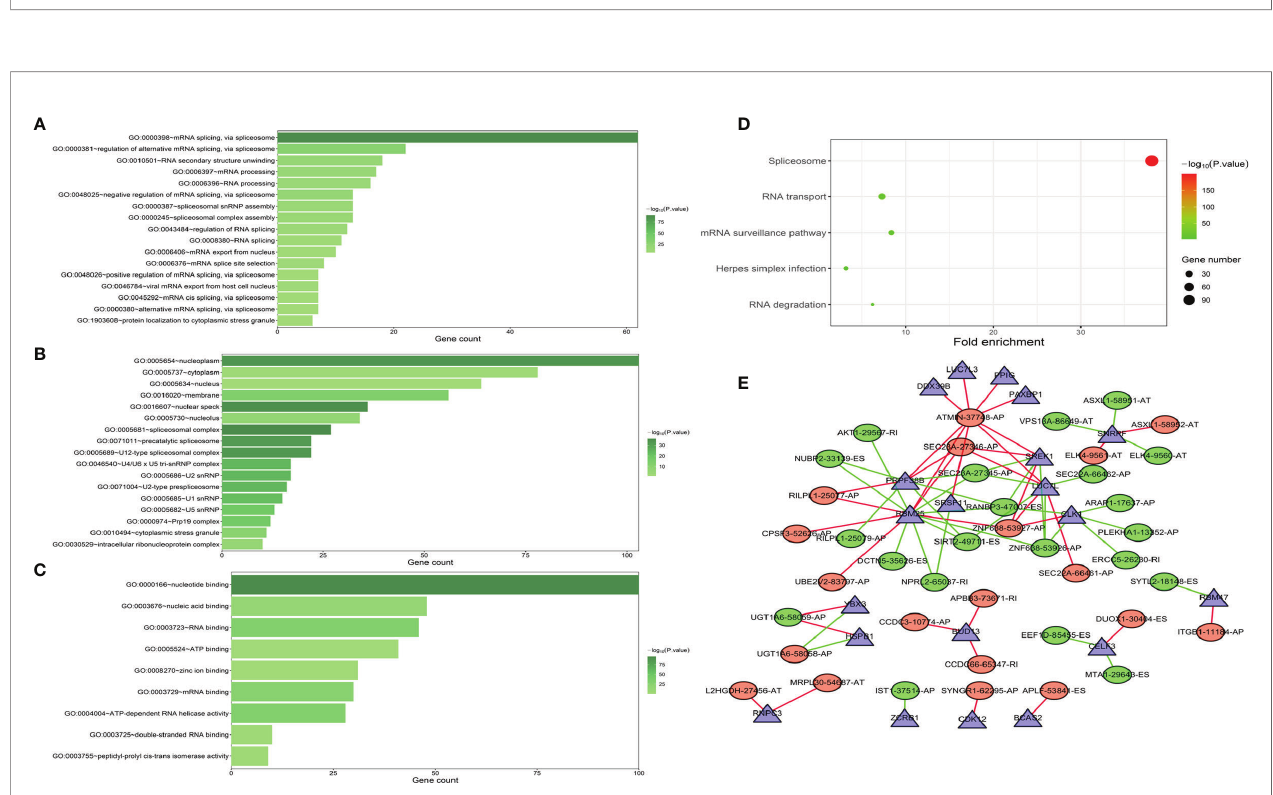
FIGURE 8 | GO functional enrichment (A – C) and KEGG pathway enrichment (D) analyses of splicing factor (SF) genes that were correlated with AS events associated with survival. The interaction network indicated the hub SFs and AS events (E) .